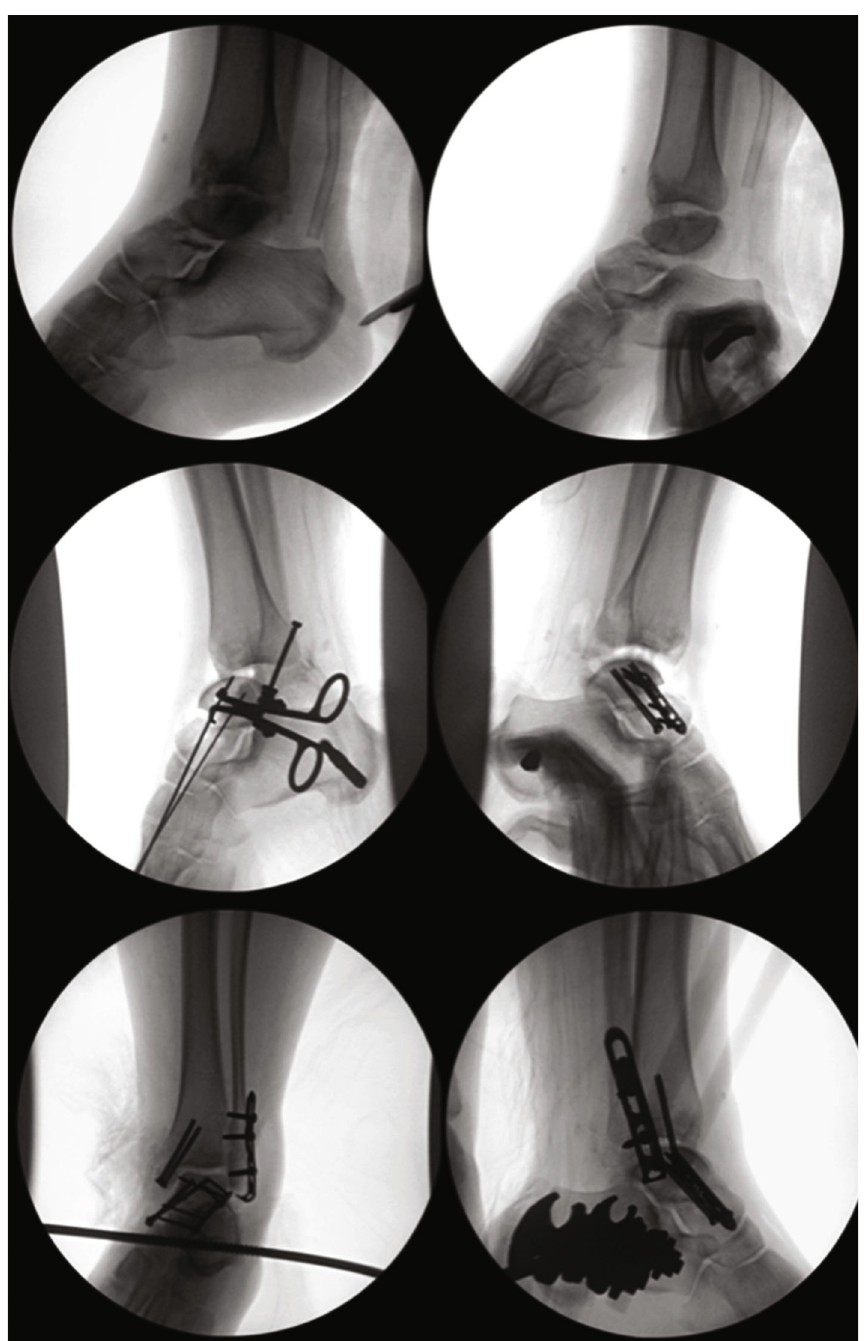
Figure 2: Intra-operative fl uoroscopy demonstrates initial calcaneal pin traction, reduction through dual incision approach utilizing the bimalleolar fracture planes, mini fragment plate fi xation of lateral talar neck and screw fi xation of medial aspect, fi xation of bimalleolar fracture, and fi nal external fi xator